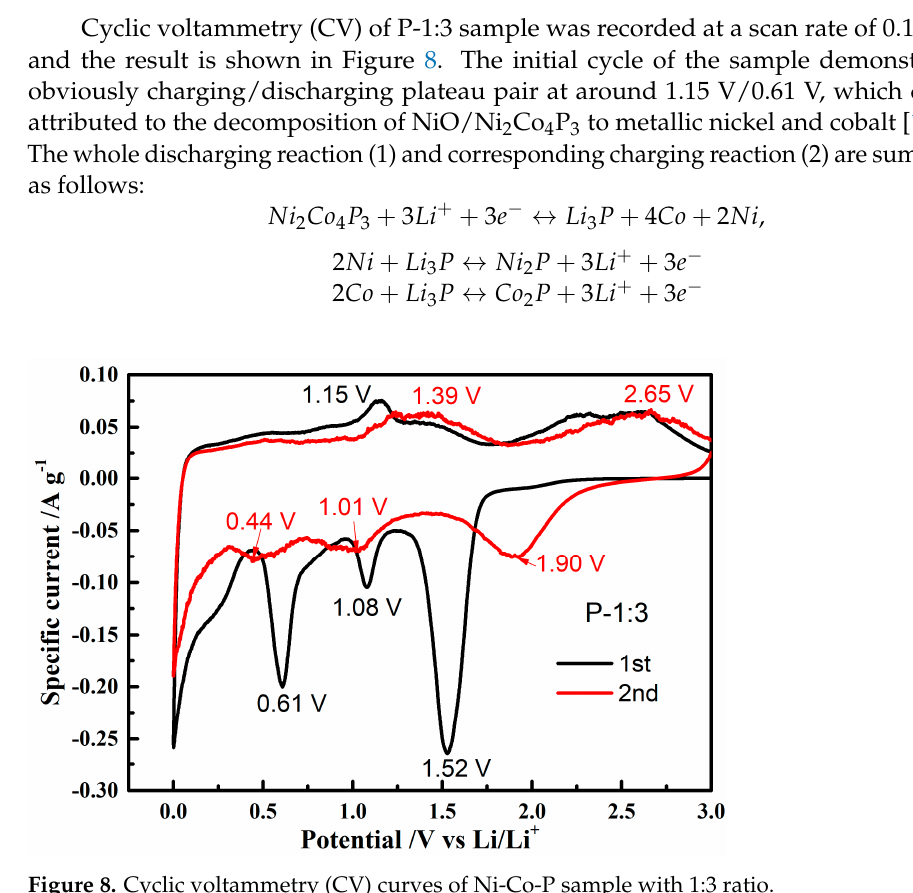
Figure 9. Surface morphology of P-1:3 sample before/after test.